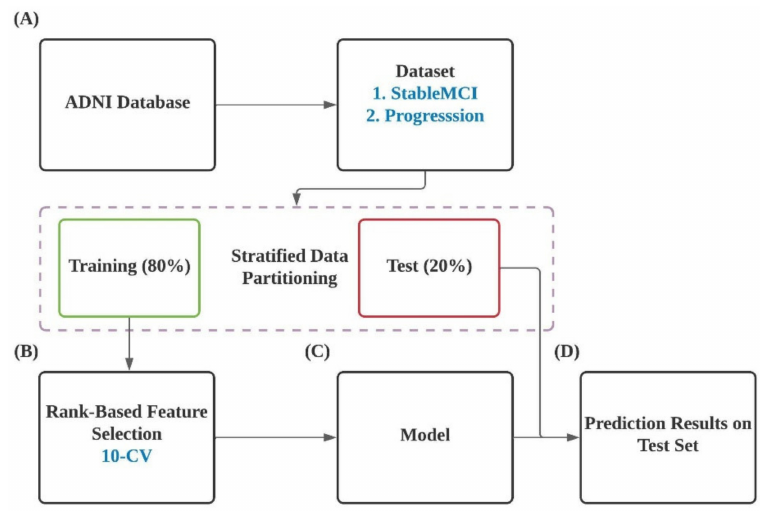
Figure 1. Flow diagram of the present work.